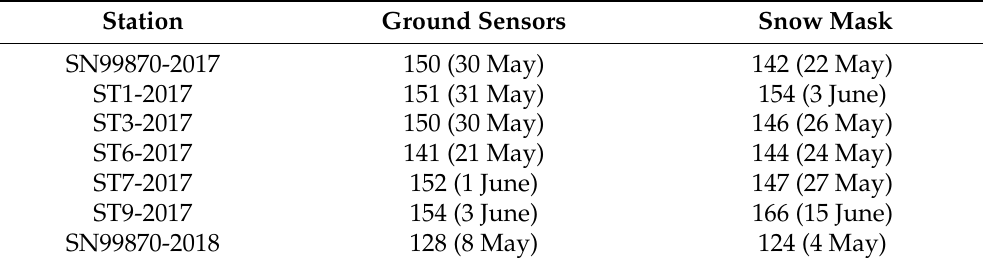
Table 3. First snow-free Day Of Year (DOY) detected by ground station and S-2 snow masks. The 2018 ground stations acquired data staring from May 23, already a snow free period. For this reason only the information of the climatic station (SN99870) was